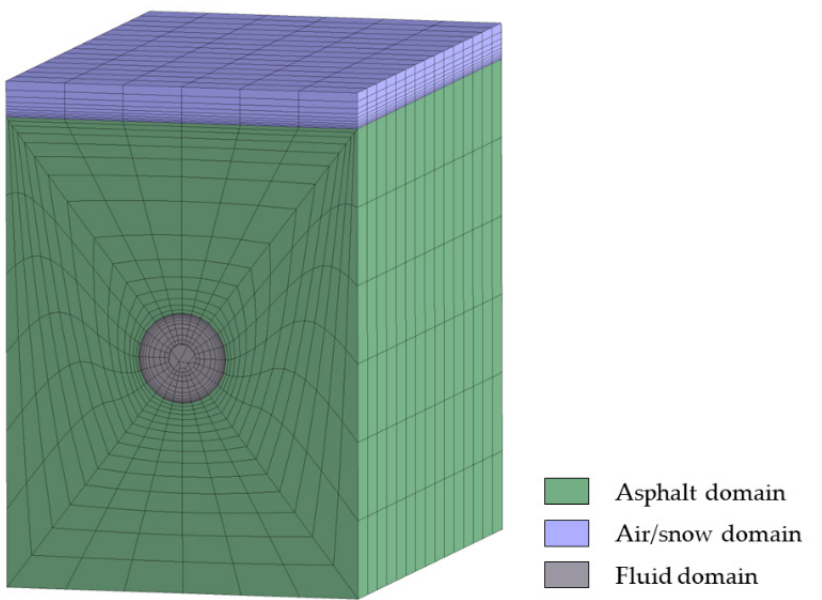
Figure 6. Close-up view of mesh in asphalt, heating fluid, and air domain.